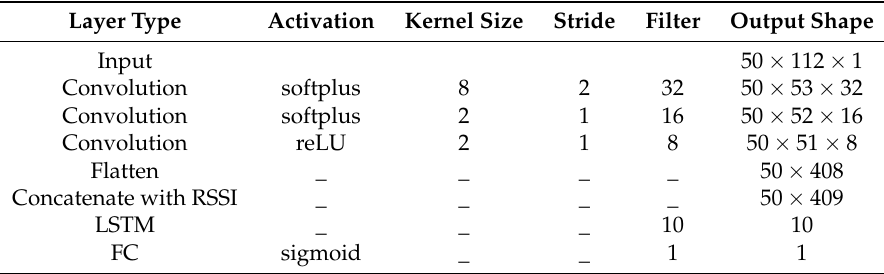
Table 1. Details of proposed CNNLSTM